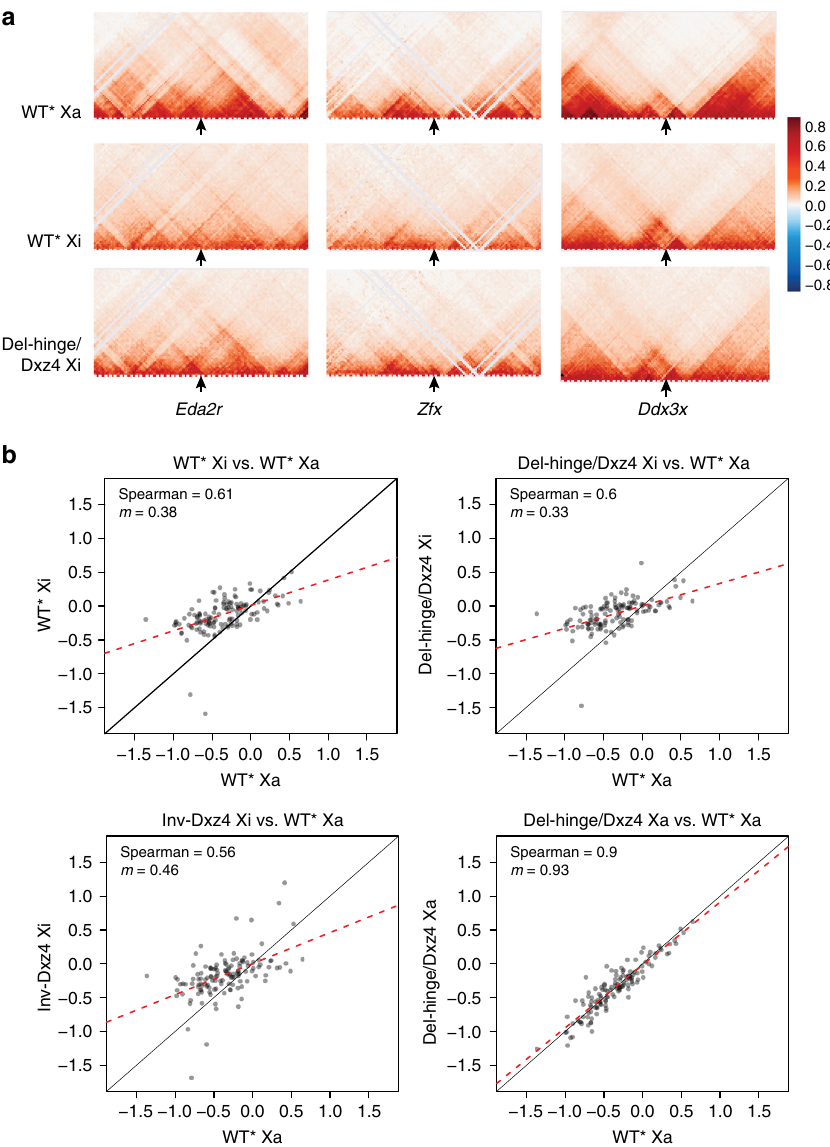
Fig. 5 Local changes in TAD structure after Dxz4 deletion or inversion. a Comparisons of contacts on the Xa and Xi in WT* and Del-hinge/Dxz4 at individual loci. Changes in TAD con fi guration at 40 kb resolution are shown within 4 Mb regions, each centered at a speci fi c gene, including two genes normally subject to XCI, Edar2 and Zfx , and a gene that escapes XCI, Ddx3x . b Scatter plots of WT* Xi, Del-hinge/Dxz4 Xi, Inv-Dxz4 Xi, and Del-hinge/ Dxz4 Xa insulation scores at the TAD boundaries identi fi ed on WT* Xa. The dash red line shows the correlation between the samples as a linear fi t, while the black line shows the expected fi t for perfectly correlated